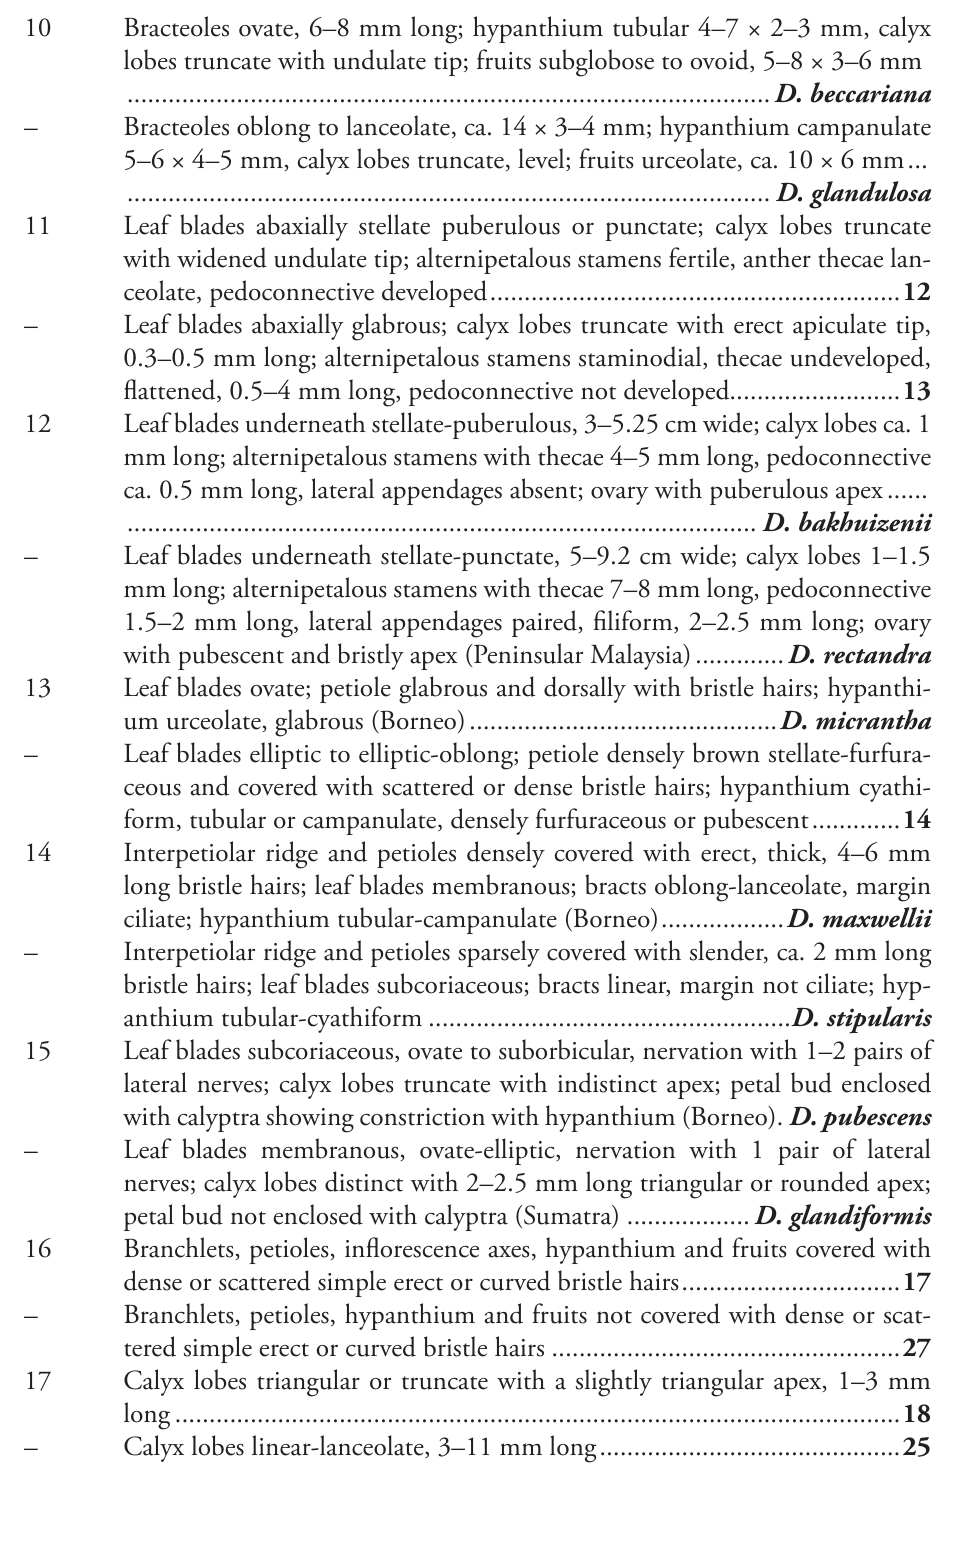
Bracteoles ovate, 6–8 mm long; hypanthium tubular 4–7 × 2–3 mm, calyx lobes truncate with undulate tip; fruits subglobose to ovoid, 5–8 × 3–6 mm Bracteoles oblong to lanceolate, ca. 14 × 3–4 mm; hypanthium campanulate